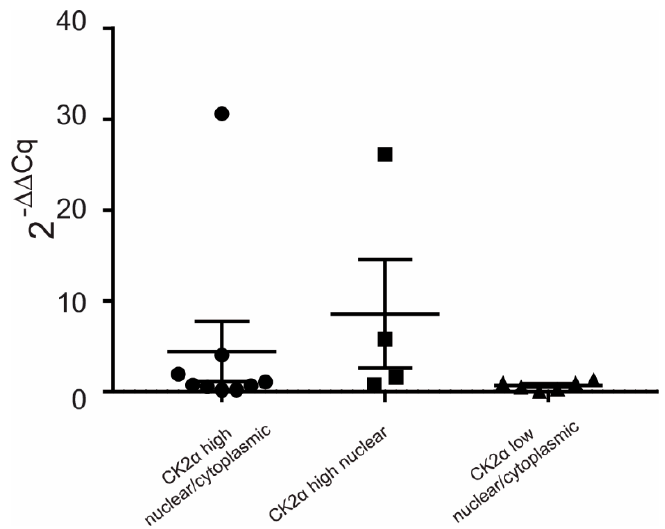
Figure 6. Analysis of CK2 α mRNA expression in CRCs. mRNA was isolated from FFPE CRC tissue and corresponding normal adjacent mucosa and transcribed into cDNA. RT ‐ qPCR was performed using TaqMan ® Gene Expression assays for CK2 α (CSNK2A1; Hs00751002_s1) and ribosomal RNA 18S (Hs99999901_s1 18S ‐ FAM, Applied Biosystems, USA) as housekeeping gene. The relative CK2 α mRNA levels tended to be higher in high nuclear/cytoplasmic and in high nuclear CK2 α‐ expressing CRC tissue. Low nuclear/cytoplasmic CK2 α‐ expressing CRCs show the weakest CK2 α mRNA ex ‐ pression. Data are expressed as means ± SEM as